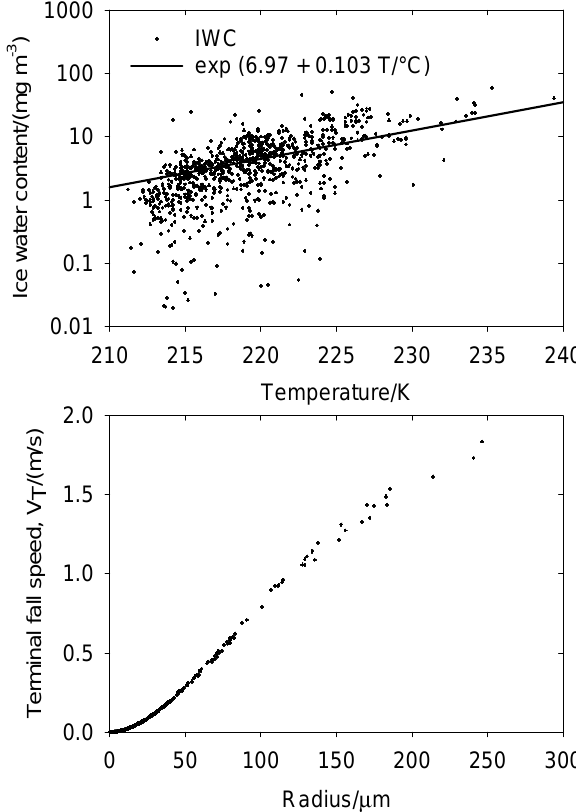
Fig. 8. Top: Ice water content versus temperature in a set of con- trail segments as in Fig. 7, compared to an empirical approximation (Schumann, 2002). Bottom: Terminal fall velocities versus particle radius Ice water content versus temperature in the same set of con- trail